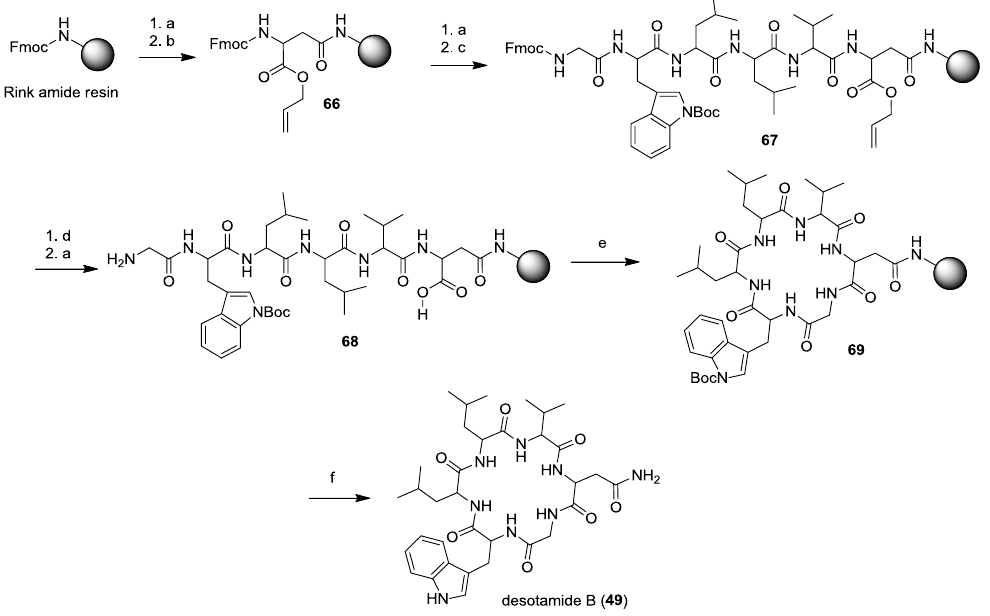
Scheme 13. Representative solid-phase peptide synthesis (SPPS) of 49 on Rink amide resin. Reagents